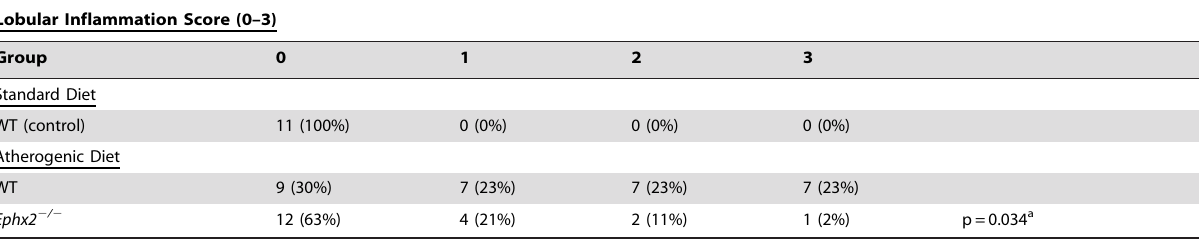
Table 1. Hepatic lobular inflammation